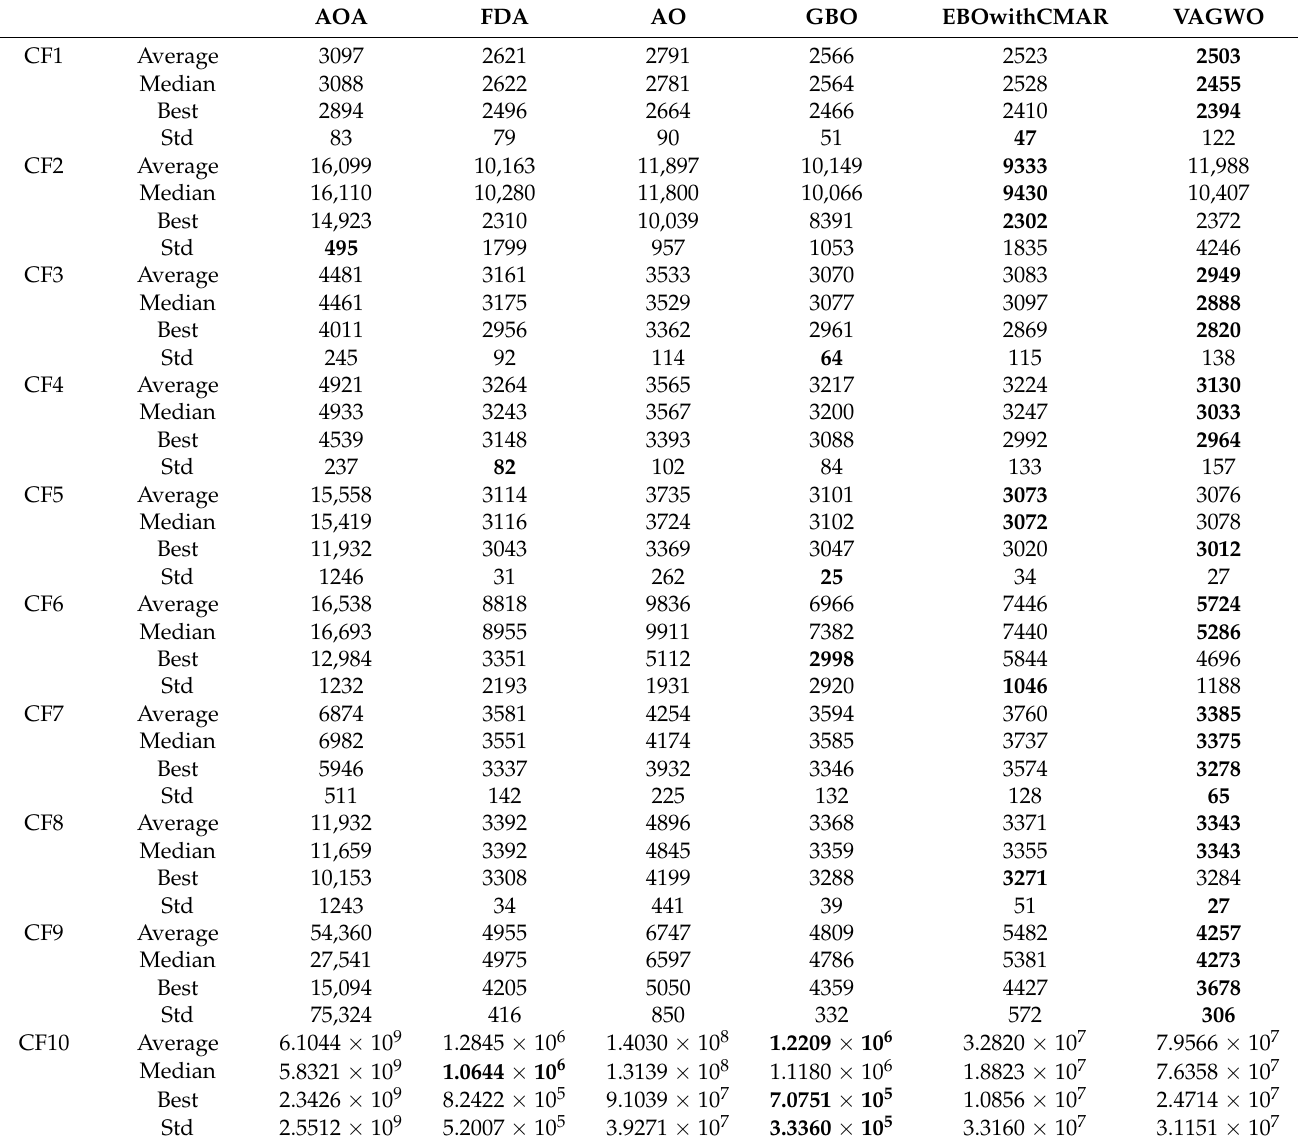
Table 8. The results achieved by the newly proposed algorithms for the composition functions (CFs) from CEC2017 at D =